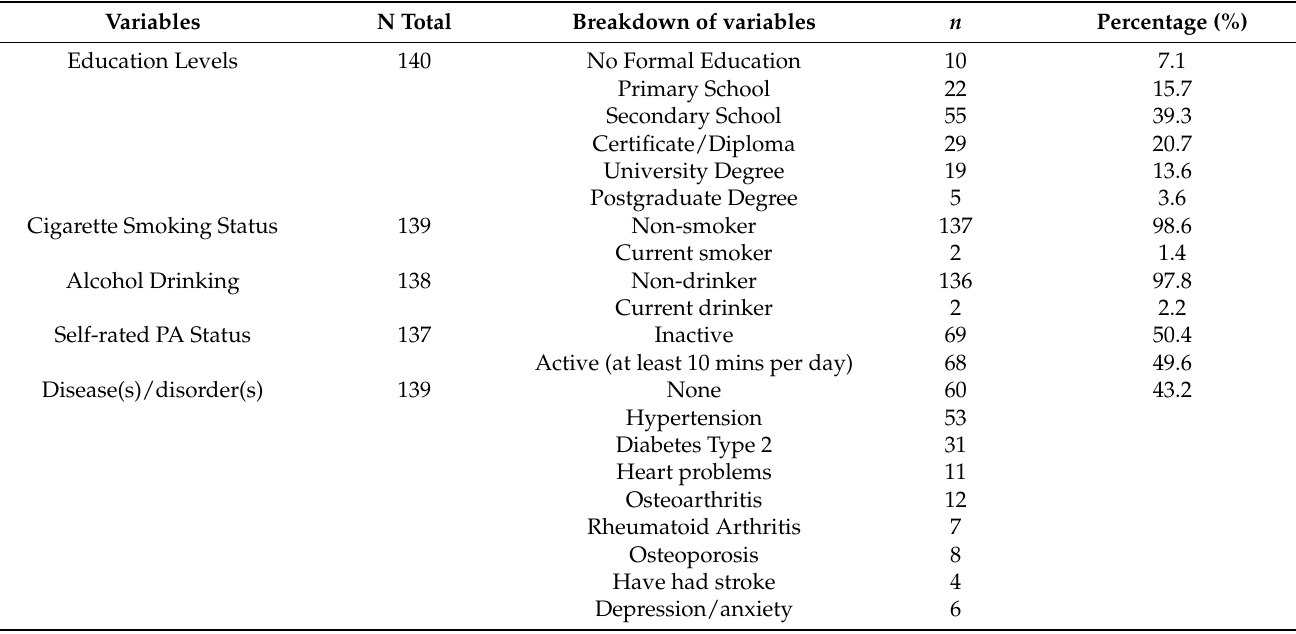
Table 2. The demographic data of study